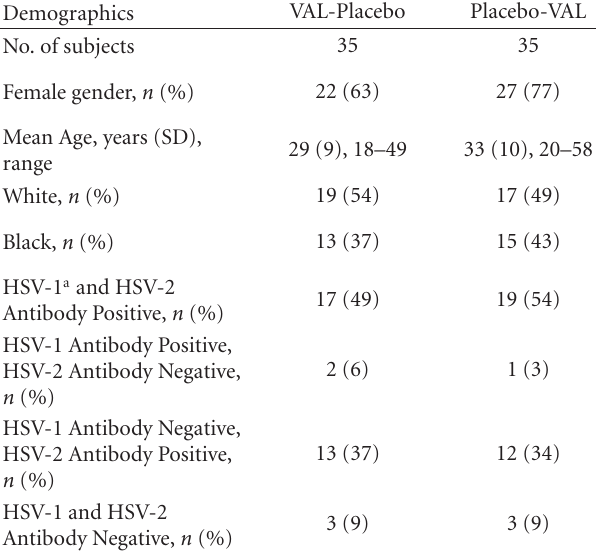
Table 1: Demographics ITT